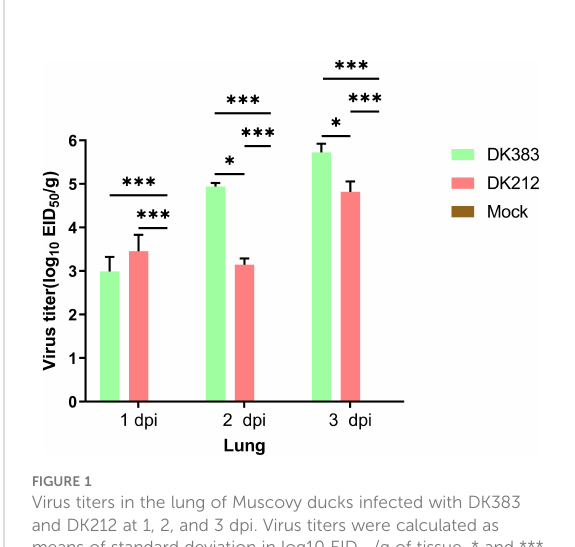
FIGURE 1 Virus titers in the lung of Muscovy ducks infected with DK383 and DK212 at 1, 2, and 3 dpi. Virus titers were calculated as means of standard deviation in log10 EID 50 /g of tissue. * and *** indicated signi fi cant differences with P ≤ 0.05 and P ≤